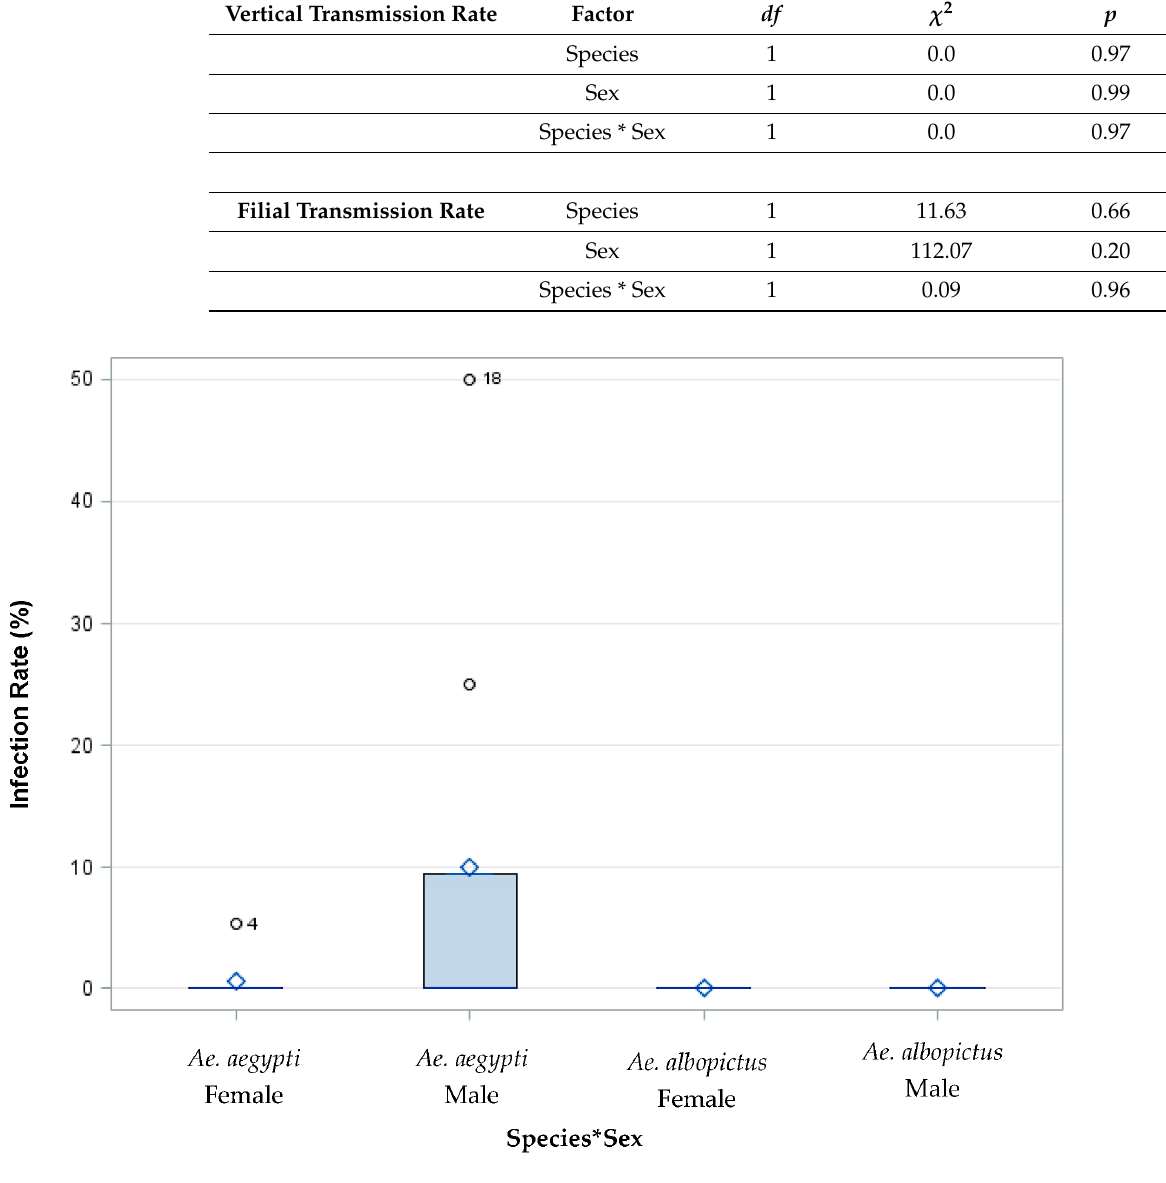
Figure 7. Saliva expectorates were examined for ZIKV from adult female progeny, and the whole bodies of adult male progeny were examined for the presence of ZIKV from parents fed 7 log 10 PFU/mL ZIKV infected blood. The analysis of variance did not show a significant difference between species, sex, or their interaction. The species by sex interaction is represented by Species*Sex. An analysis of Ae. aegypti females ( n = 30), Ae. aegypti males ( n = 26), Ae. albopictus females ( n = 5), and Ae. albopictus males ( n = 15) was performed on individual progeny